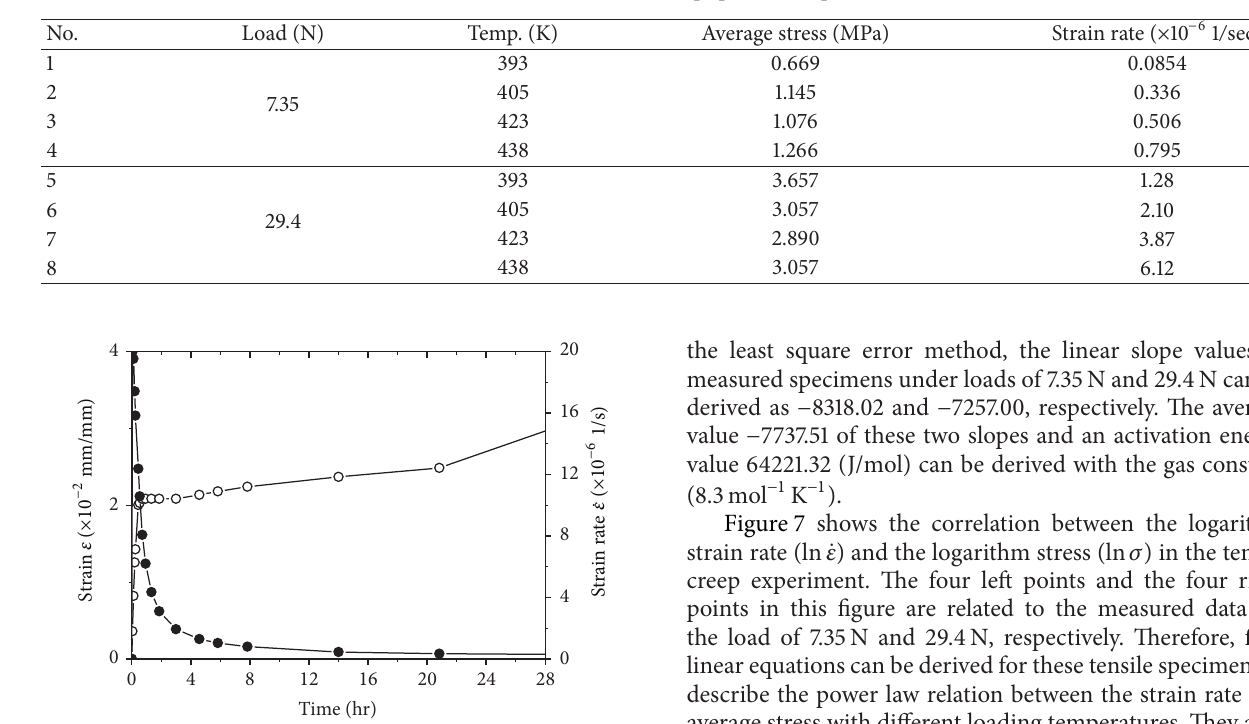
Figure 4: Correlation of displacement-time in the tensile creep experiment under different loads: (a) 7.35 N load disc and (b) 29.4 N load disc. Table 2: Results of tensile creep specimen experiment.